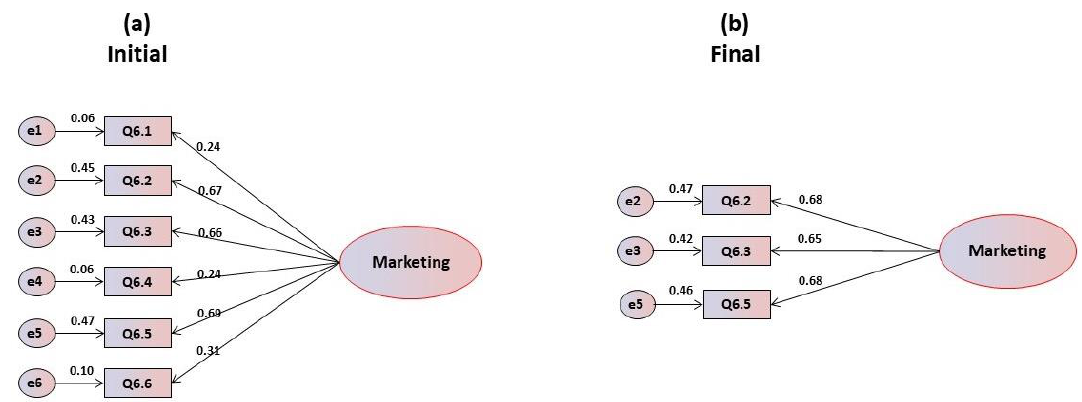
Figure 6. ( a ) Initial and ( b ) final models for the marketing and commercials motivations’ scale.